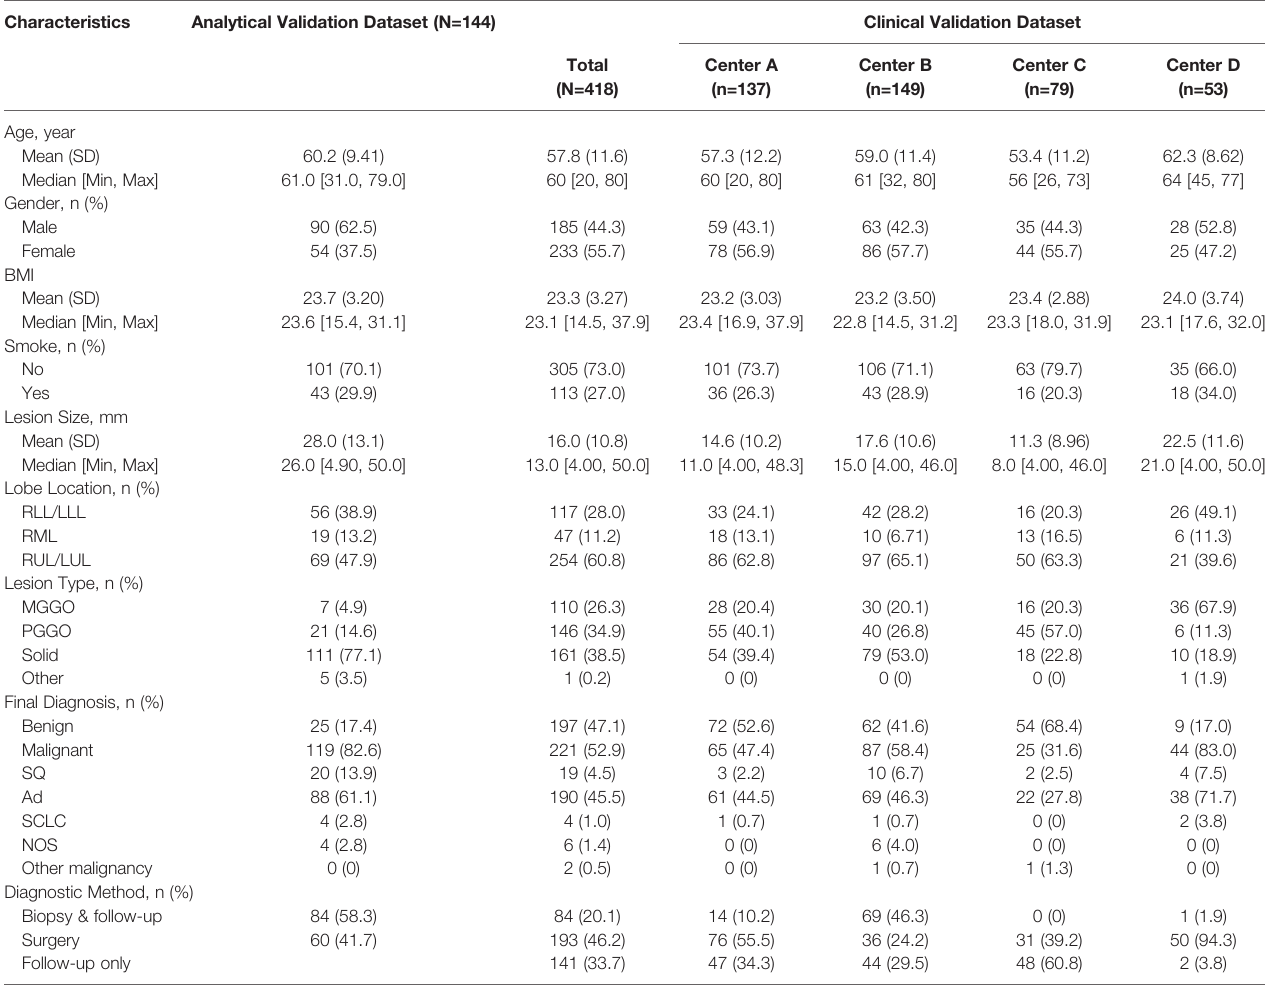
TABLE 1 | Baseline characteristics of the patients.